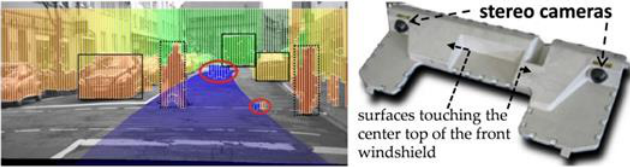
Figure 11. Right: Mounting of stereo cameras in the demo-vehicle “Bertha” of Daimler 2013; left: Objects detected by stereo vision with the ‘stixel’ approach [30,50].